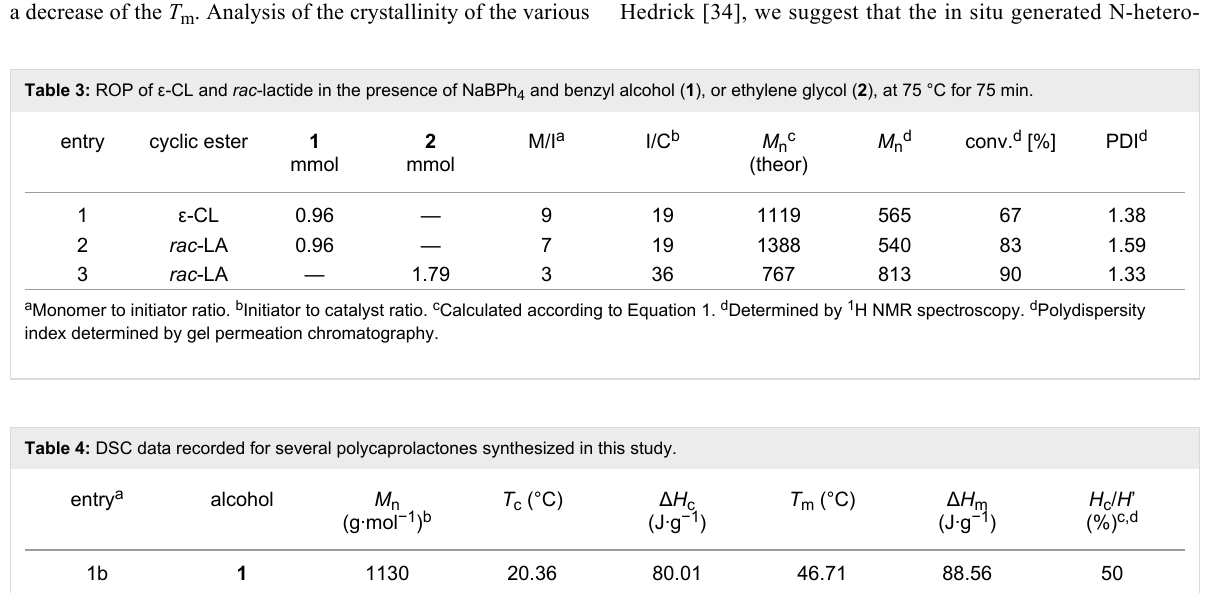
a Corresponds to the same entries of Table 1. b Determined by 1 H NMR spectroscopy. c Percentage of crystallinity. d H ’(PCL) = 161.1 J·g − 1